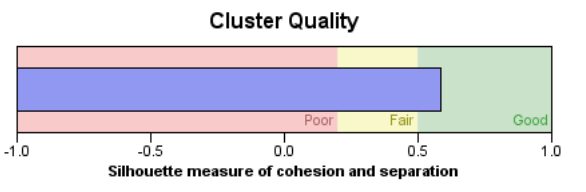
Figure 14. The relationship between post density and Young’s modulus.